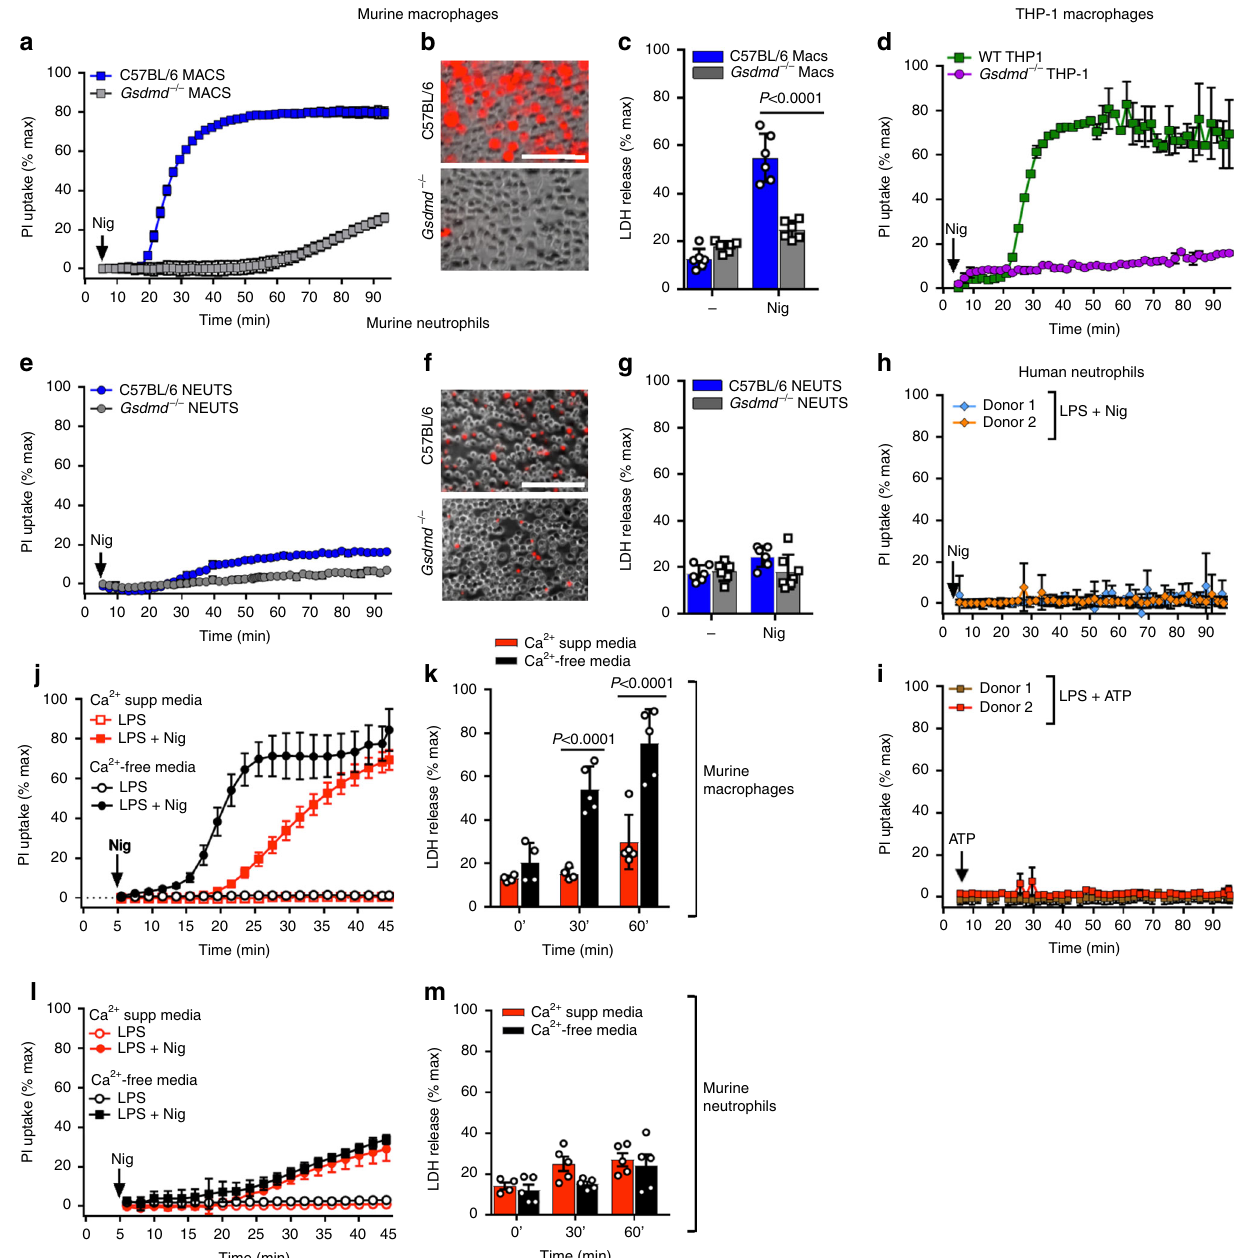
Fig. 1 Plasma membrane permeability and Ca 2 + — dependent plasma membrane repair in NLRP3-activated human and murine macrophages and neutrophils. a – c NLRP3-activated (LPS/nigericin) bone marrow derived macrophages from C57BL/6 and Gsdmd − / − mice showing a time course of propidium iodide (PI) uptake ( a ), representative PI positive cells after 45min ( b ), and LDH release after 90min ( c ). 5mM glycine was added to the extracellular media for PI imaging of C57BL/6 and Gsdmd − / − macrophages during nigericin stimulation to avoid cell lysis but was not added to neutrophil cultures. d Time course of PI uptake by LPS/nigericin activated WT and Gsdmd − / − THP-1 human macrophages. e – g NLRP3-activated bone marrow neutrophils from C57BL/6 and Gsdmd − / − mice showing PI uptake ( e , f ) and LDH release after 90min incubation ( g ). h , i PI uptake by LPS/nigericin and LPS/ATP — activated peripheral blood neutrophils from two healthy human donors. (IL-1 β production is shown in Supplemental Fig. 3). j – m PI uptake and LDH release (45min) by murine macrophages ( j , k ) and neutrophils ( l , m ) stimulated with nigericin in either Ca 2 + supplemented or Ca 2 + free media. Time course of PI uptake ( a , d , g , h , i , j , l ) are mean±SD of 4 independent experiments ( n = 4); LDH data ( c , g , k , m ) are mean±SD of biological replicates for each condition from 5 or more independent experiments ( n = 5 data points). p- Values were derived by two-way ANOVA using Sidak ’ s multiple comparisons test; p <0.05 is signi fi cant, n.s .: not signi fi cant. Panels B, F: scale bar = 100 µ m. Source data for panels a , c , d , e , g , h , i , j , k , l , m are provided in the separate Source Data fi membranes to the actions of pore-forming proteins. C57BL/6 and macrophages exhibited greater PI in fl ux compared to Gsdmd − / − macrophages in response to Ply (Supplementary Fig. 5a). We Gsdmd − / − neutrophils were stimulated with sub-lytic concentra- tions of the Streptococcus pneumoniae exotoxin pneumolysin used the NLRP3 inhibitor MCC950 to show that this was due to (Ply), which is a MACPF/CDC protein. Ply induced robust PI the combined actions of primary in fl ux via Ply pores plus in fl ux in both neutrophils and macrophages, although C57BL/6 secondary in fl ux via N-GSDMD pores, which accumulate as a